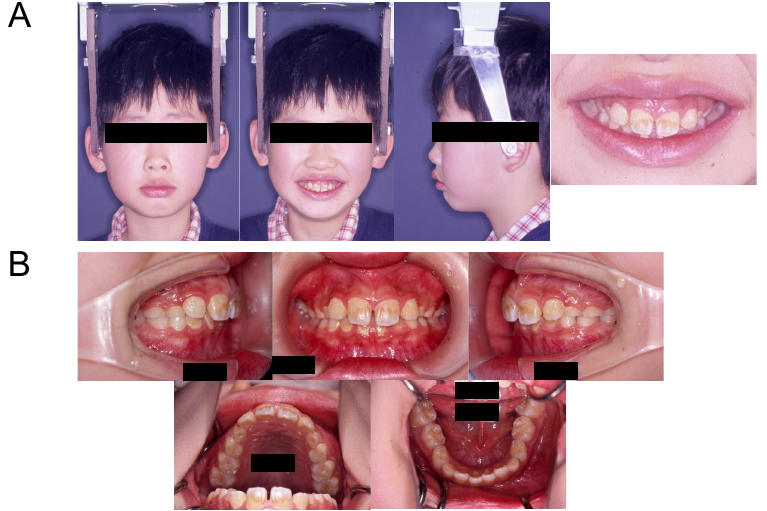
Figure 2. Facial photographs and intra-oral photographs at initial examination for Case 1; facial photograph and enlarged photograph of the mouth at initial examination ( A ); intra-oral photograph at initial examination ( B ).